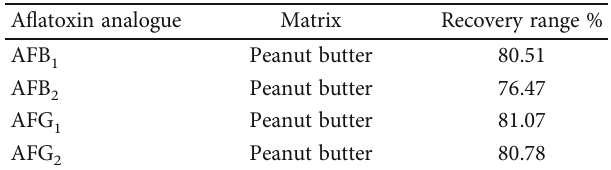
Table 1: Recoveries (%) of each a fl atoxin analogue at 5 μ g/kg spiking level.